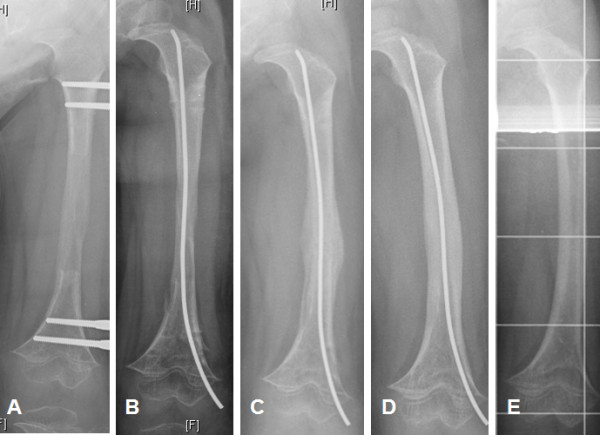
A-D Radiographic examination and diagnosis of a fracture in the regenerate during treatment. Boy (No 5 in Table 2) with femoral lengthening due to achondroplastic short stature, 5 years old: A) at the day of the removal of the fixator. B) day 0, after removal of the frame, one TEN was inserted due to prophylactic stabilization. C) x-ray at day 50 after removal shows a new callus formation within the regenerate, it must have been a fracture type 1b weeks ago, estimated caused by manipulation during insertion of the TEN, no other reason was applicable. D) 4 months (day 133) after removal of the fixator, before removal of the TEN with bony healing without loose of length or development of further malformation. E) late follow up, 1 year after removal of the TEN.